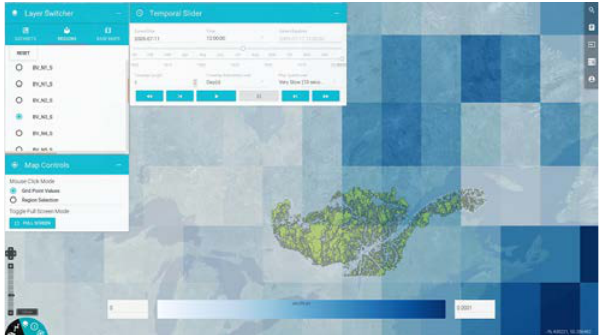
Figure 2. The PAVICS Research Platform